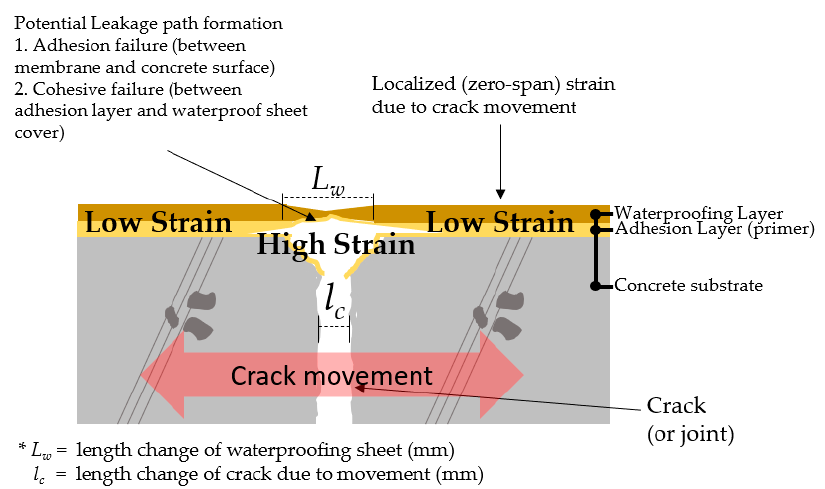
Figure 2. Strain concentration directly above the moving crack on waterproofing material illus- trated.